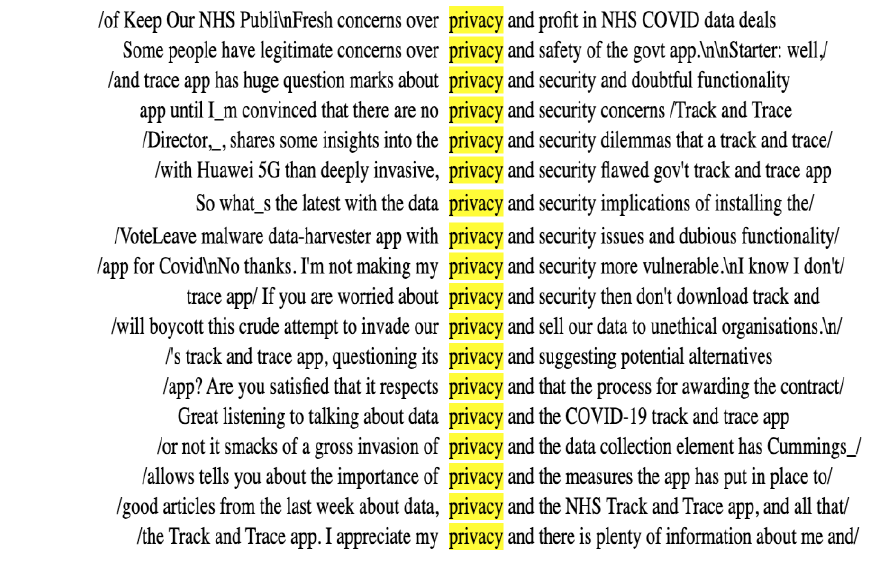
Figure 3. Example of the keyword-in-context display for